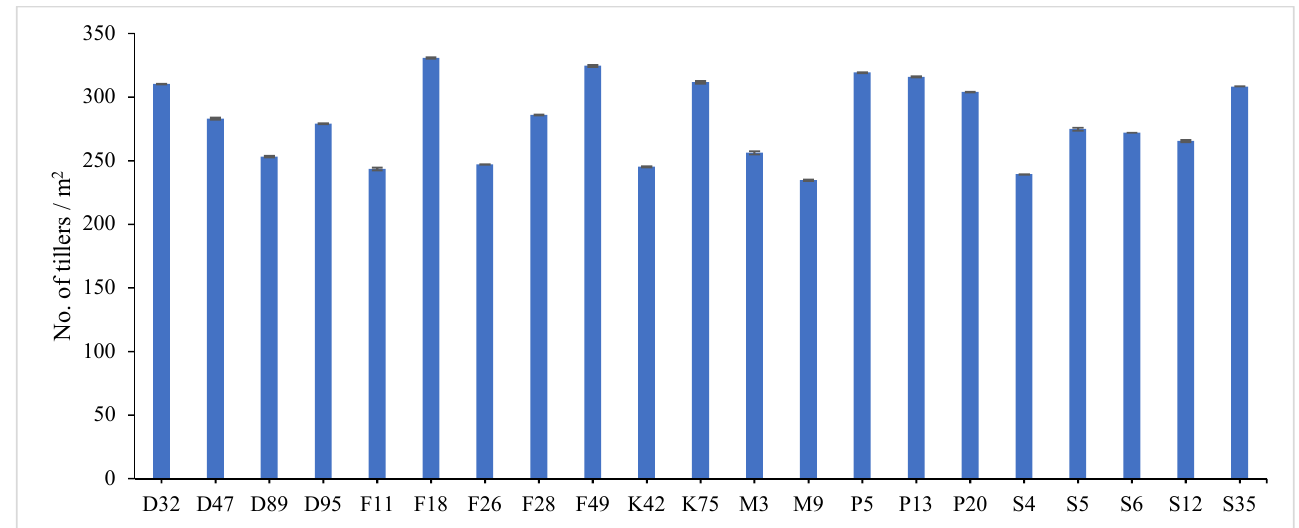
Figure 1. Mean performance of plant height, of twenty-one alfalfa genotypes at combined across the two years. Bar represents the standard deviation.